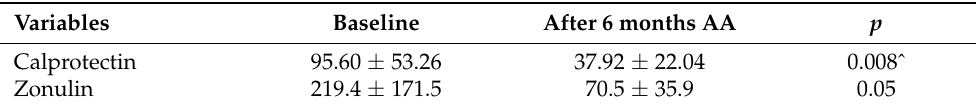
Table 5. Measures associated with intestinal mucosa inflammation (calprotectin, µ g/g) and perme- ability (zonulin, ng/ml) of Chronic Kidney Disease (CKD) patients at baseline and after 6 months of AA